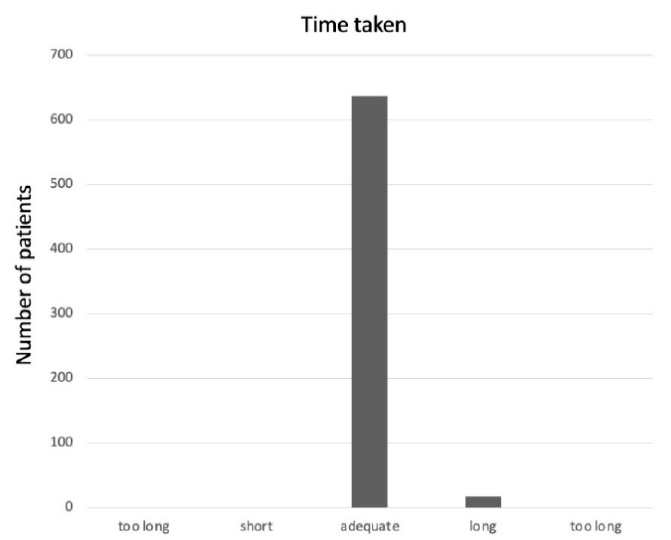
Figure 1. Acceptability of pGALS about the time taken (on the Likert scale).